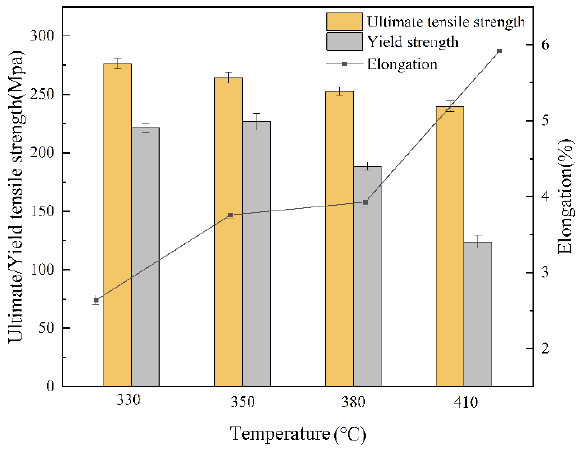
Figure 6. Comparison of mechanical properties of SLMed AZ61 magnesium alloy under different T4 treatment temperatures.